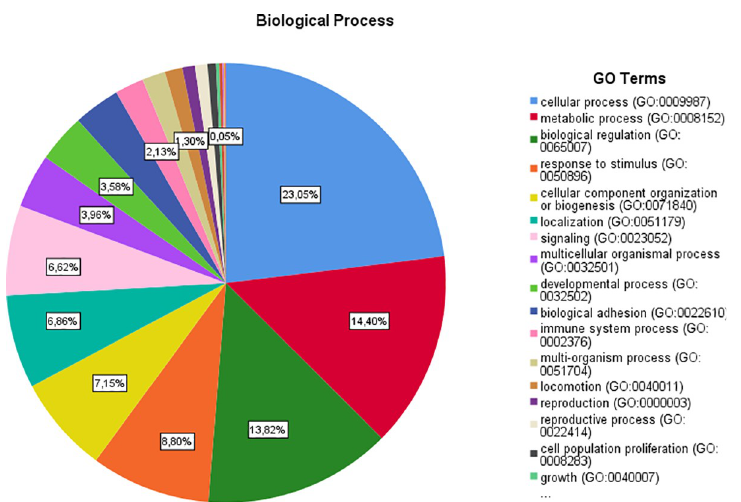
Fig 3. Results of “biological process”